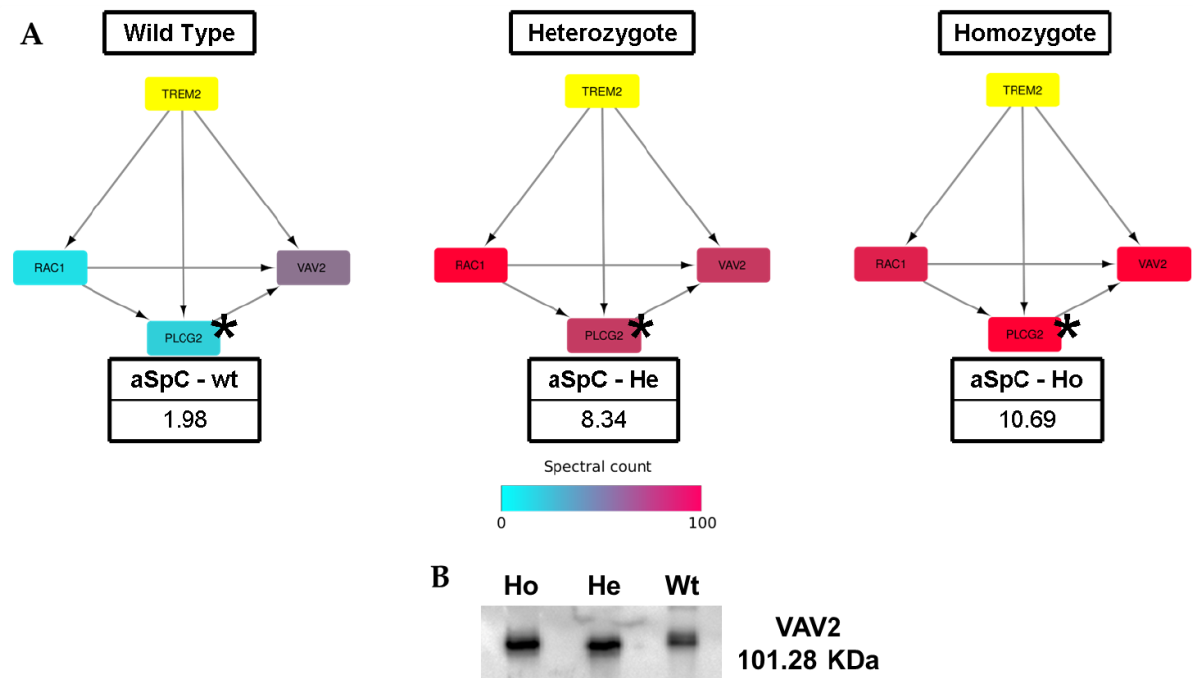
Figure 5. Trem2 Interactor Proteins. ( A ) Three different proteins associated with the TREM2 network were highlighted: RAC1, PLCG2 and VAV2. These interactor proteins were upregulated in NHD patients (Ho) in comparison with healthy subjects (Wt). ( B ) Western blotting of VAV2 protein. * Statistically significant value.